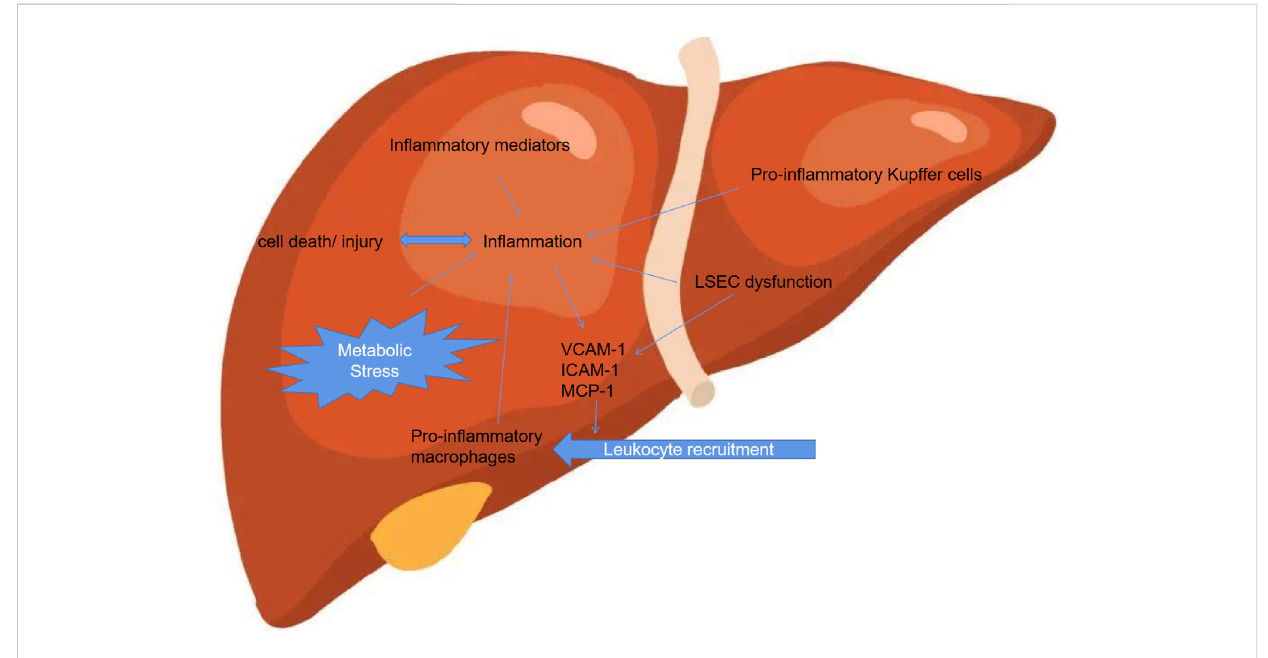
In fl ammation associated with